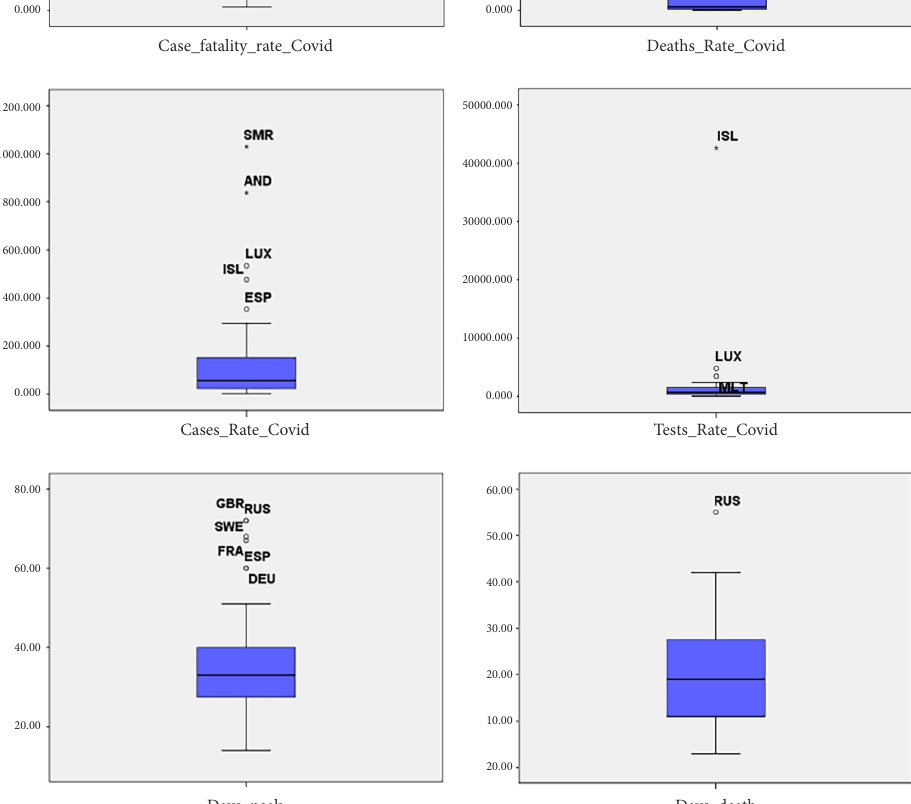
Figure 1. Box-plots for Covid-19 Indicators (source: authors’ computation using IBM SPSS Statistics The variable days_first death is the only one of the category of Covid-19 indicators that meets the normality hypothesis. The median is much lower (19 days) compared to the previ- ous analysed indicator, but the difference between the highest and the smallest value is larger (52 days compared to 49 days in the case of days_peak variable). The smallest value (3 days) was recorded by Albania, while the largest (55 days) by the Russian Federation (Figure 1). Among the indicators that measure the mortality incidence, only crude _ death_rate meets the hypothesis of normality (Shapiro-Wilk Statistic = 0.980, sig. = 0.568). The lowest crude_